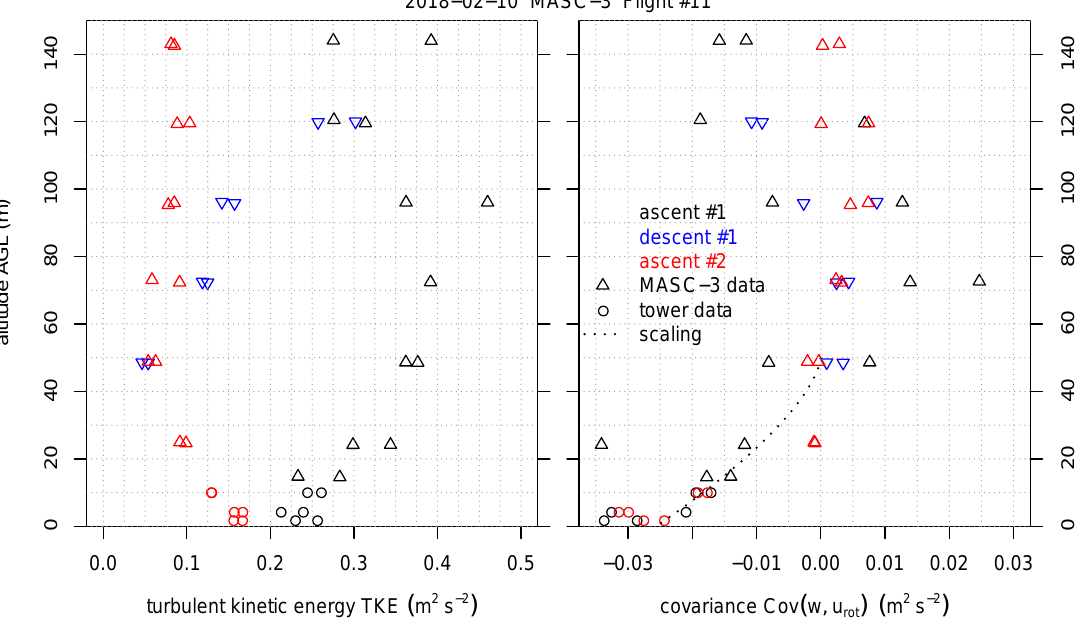
Figure 16. MASC-3 Flight #11 alongside the corresponding tower data as height profile for the TKE ( left ) and the covariance Cov wu ( right ) of the vertical wind w and the transformed vector component rot u h which is aligned with the mean wind direction. The time series of the tower data points have a duration of ∆ t tower = 170 s, corresponding to the fetch of the MASC-3 flight legs at the lowest levels with an average duration of ∆ t UAS = 55 s. The Cov wu profile ( right ) inherits the scaling rot